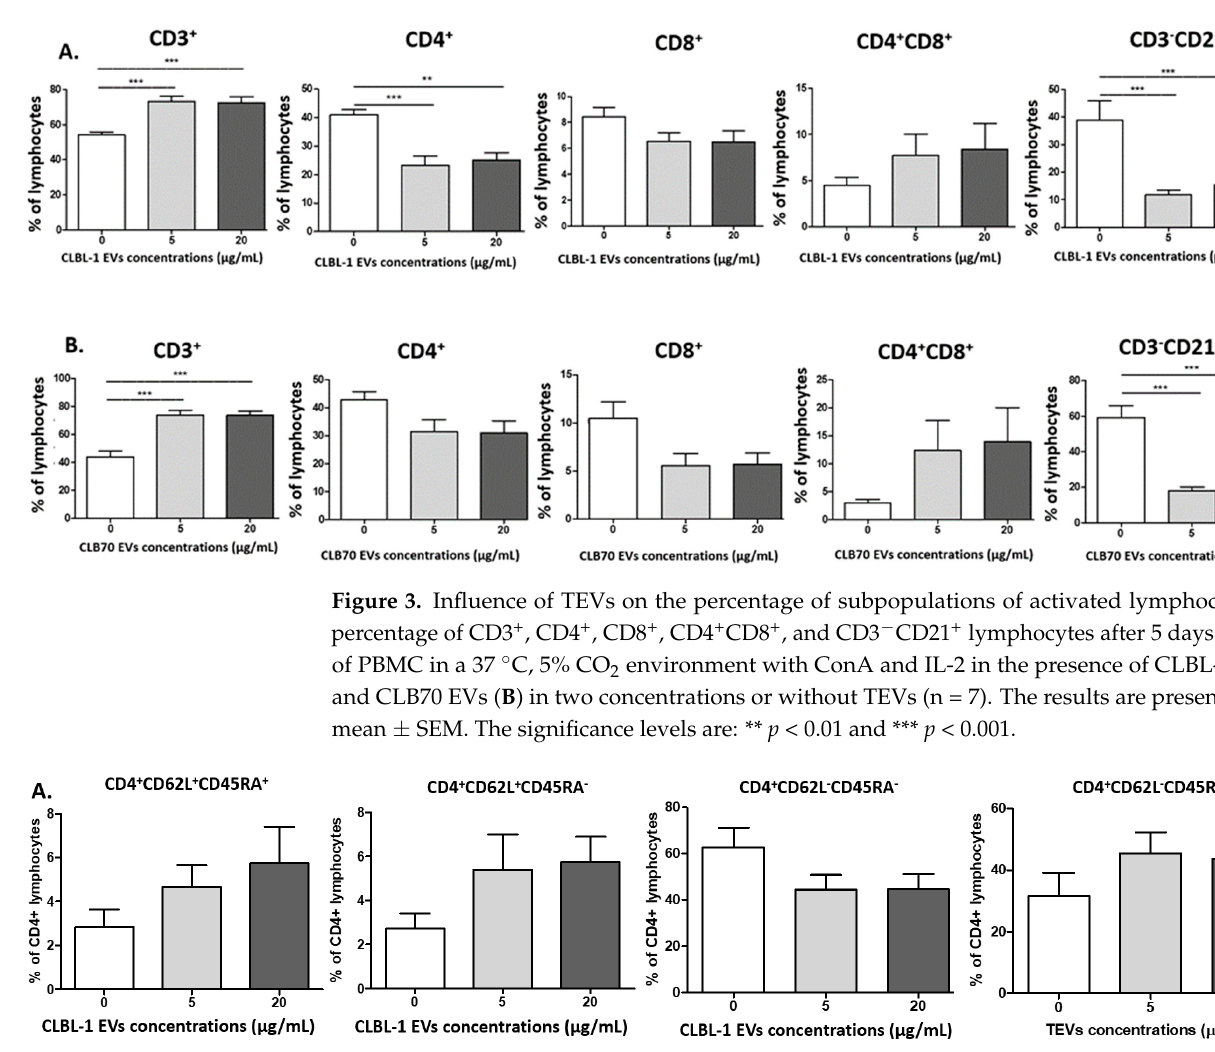
Figure 5 . Influence of TEVs on the percentage of activated memory CD8 + lymphocytes. Changes in frequencies of canine CD4 + and CD8 + lymphocytes after 5 days culture of PBMCs in a 37 °C, 5% CO 2 environment with ConA and IL-2 in the presence of CLBL-1 EVs ( A ) and CLB70 EVs ( B ) in two concentrations or without TEVs (n = 7). The results are presented as the mean ± SEM. The significance level is: * p < 0.05.